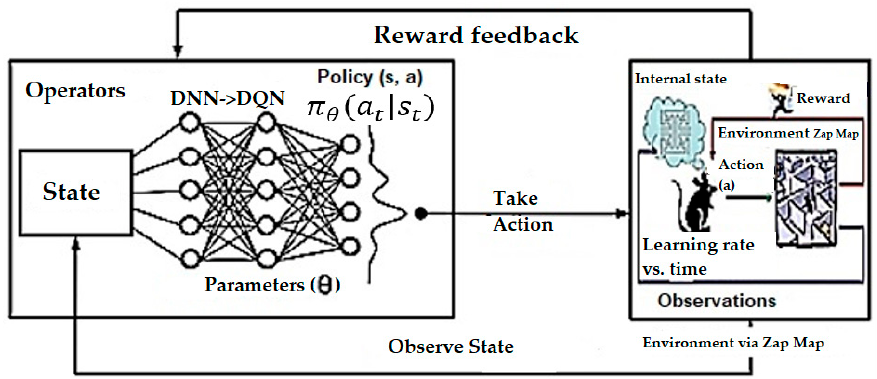
Figure 1. The architecture of the deep learning.